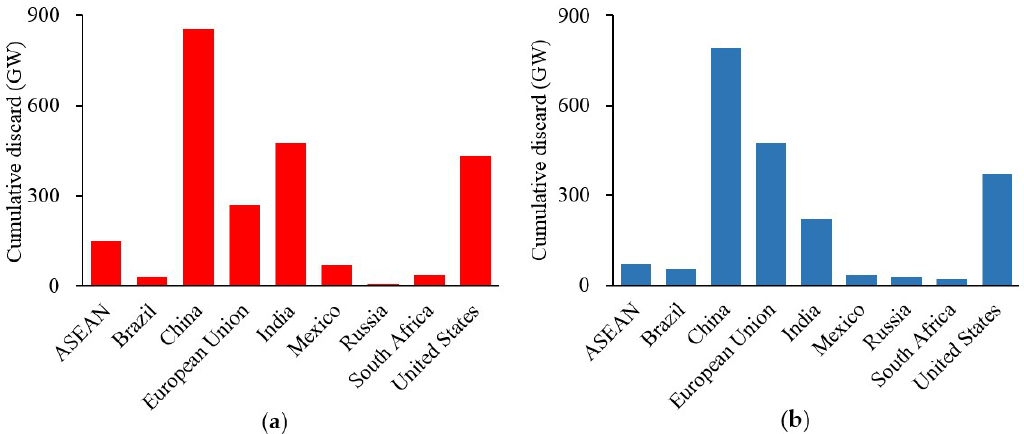
Figure 16. Cumulative discards by region from 2016 to 2060. ( a ) solar power ( b ) wind power.